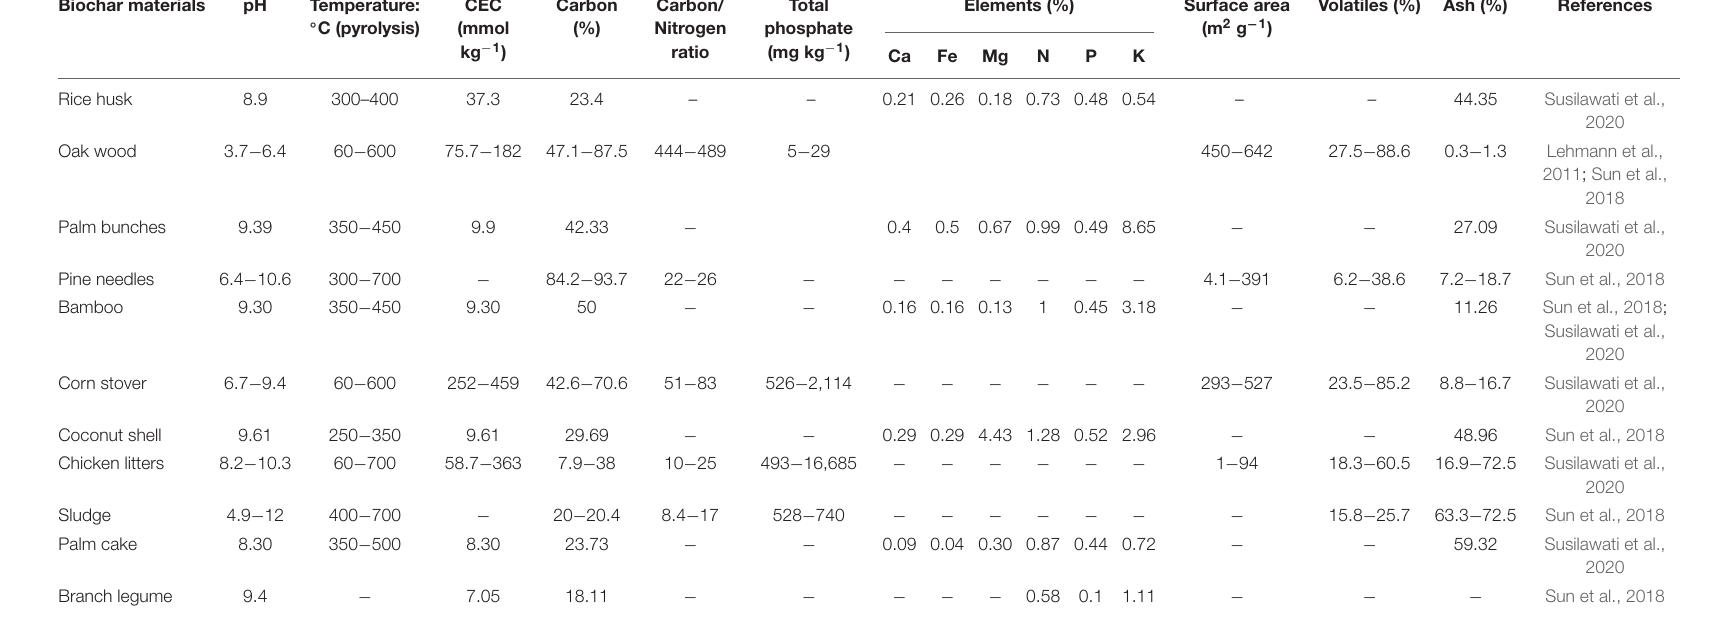
TABLE 1 | Physical and chemical properties of biochar obtained from various plant residues and